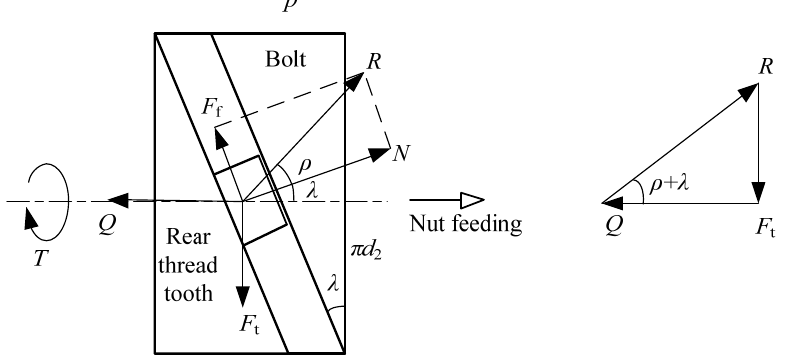
Figure 4. Force states between hi-lok nut (block) and bolt.